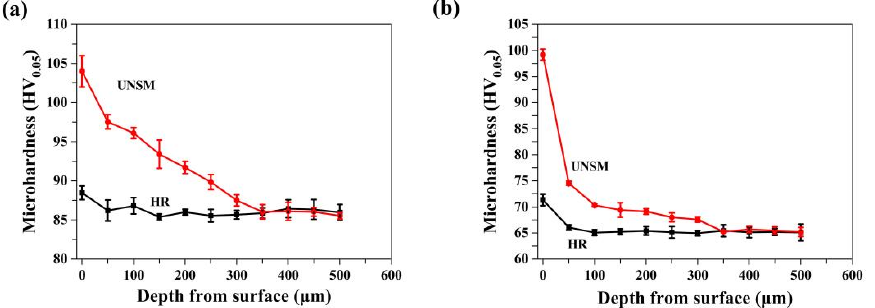
Figure 7. Microhardness distribution of the cross-sections of LAE361 Mg-Li alloy ( a ) and LA106 Mg-Li alloy ( b ) before and after UNSM treatment.